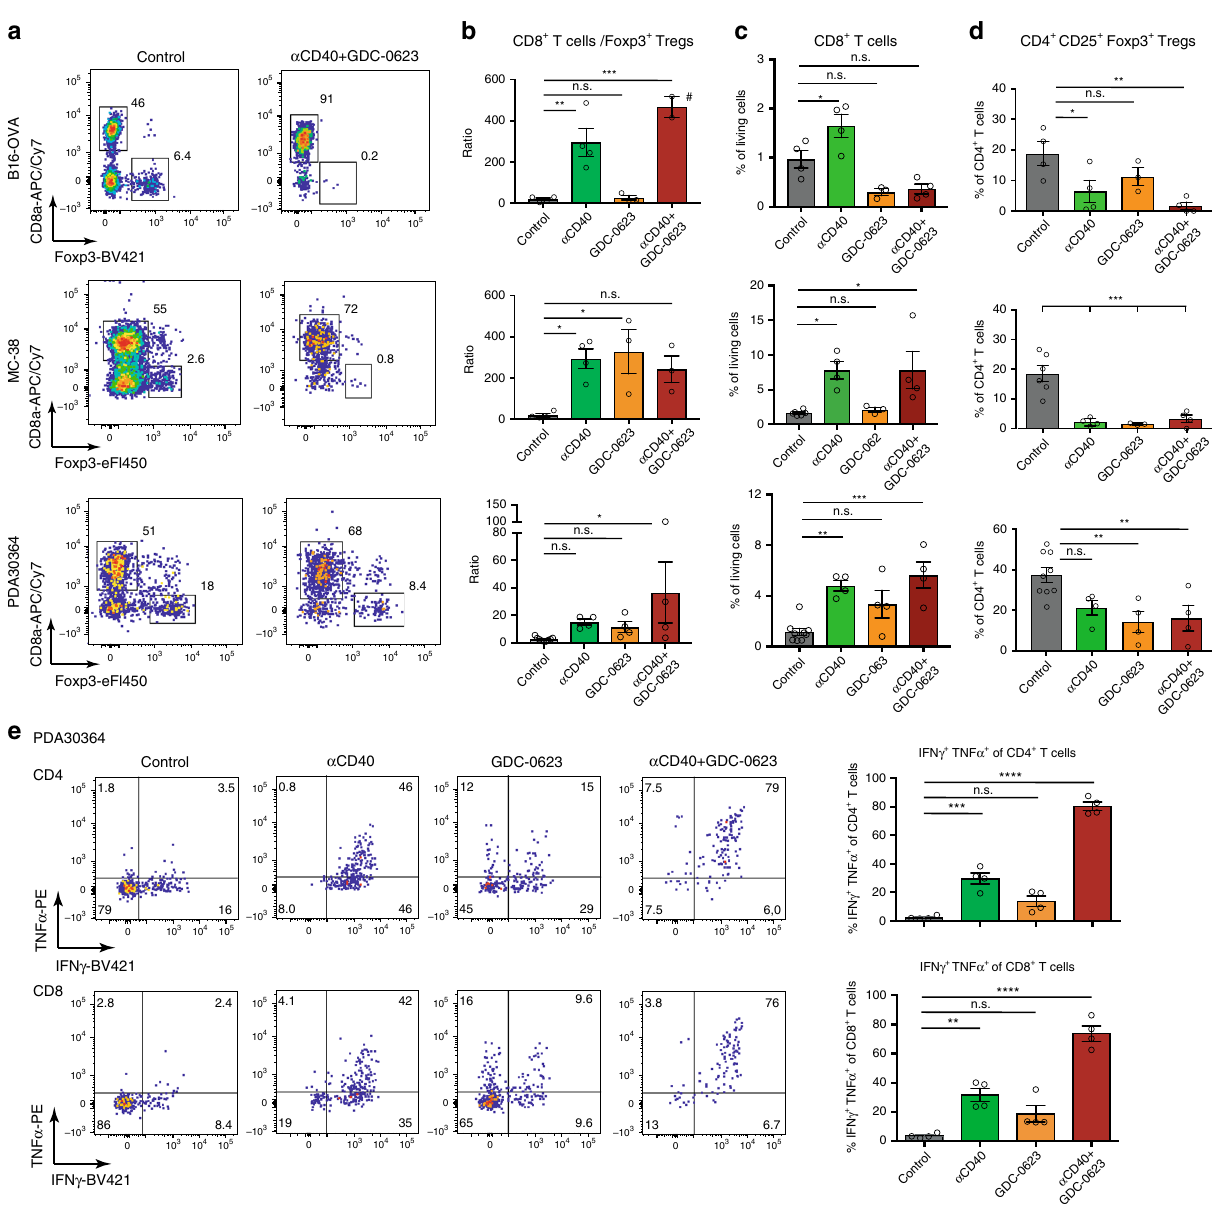
Fig. 4 MEKi/anti-CD40 Ab combination therapy increases CD8/Treg ratio and effector function of tumor-in fi ltrating T cells. a Flow cytometric analysis of the impact of MEKi GDC-0623 and/or anti-CD40 Ab treatment on the T cell in fi ltrate in B16-OVA, MC-38, and PDA30364 tumors, as performed on four mice per treatment group of the experiments shown in Fig. 3a – c. Representative dot plots are shown. Cells were pre-gated on living, CD45 + , CD3 + , Thy-1.2 + cells. b – d Quantitation of CD8 + T cell to CD4 + CD25 + Foxp3 + regulatory T cell ratio, regulatory T cell frequencies among CD4 + T cells, and CD8 + T cell frequencies among living cells. # Two animals without Tregs. One-way ANOVA with post hoc Dunnett ’ s test (treatment groups vs. control). Mean ± s.e.m, n = 4. e TILs isolated from PDA30364 tumors were restimulated ex vivo with PMA/Ionomycin in presence of GolgiPlug and stained for intracellular IFN γ and TNF α . Mean ± s.e.m., n = 4. One-way ANOVA with post hoc Tukey ’ s test. Signi fi cance levels are indicated by asterisks (* p ≤ 0.05; ** p ≤ 0.01; *** p ≤ 0.001; **** p ≤